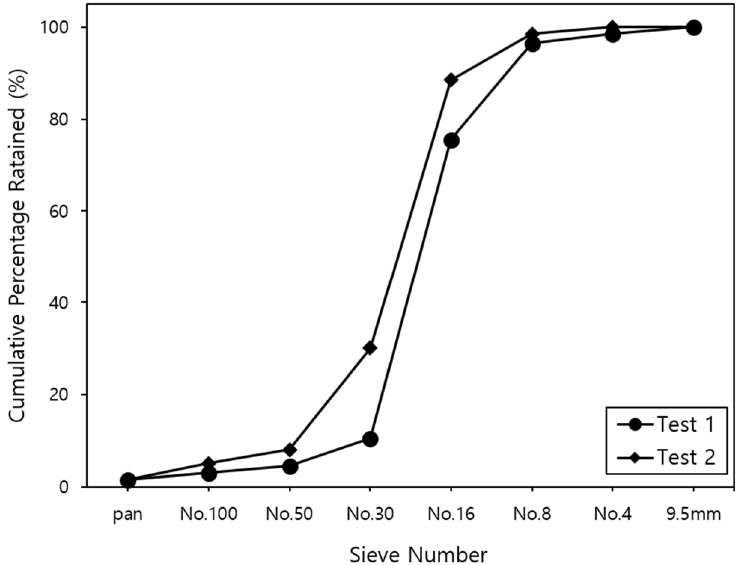
Figure 1. Gradation curves for the used fine-rubber particles.